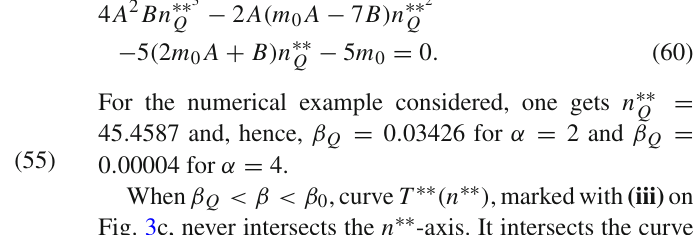
Fig. 3c, never intersects the n ∗∗ -axis. It intersects the curve Q ( n ∗∗ ) at points with n ∗∗ coordinates given by ξ ∗∗ . Criti- 1 , 2 < n ∗∗ < ξ ∗∗ are stable. Finally, when cal points with ξ ∗∗ 1 2 ∗∗ ( n ∗∗ ) , marked with (iv) on Fig. 3c, never β < β Q , curve T intersects the n ∗∗ -axis or the curve Q ( n ∗∗ ) . There are no stable critical points in this